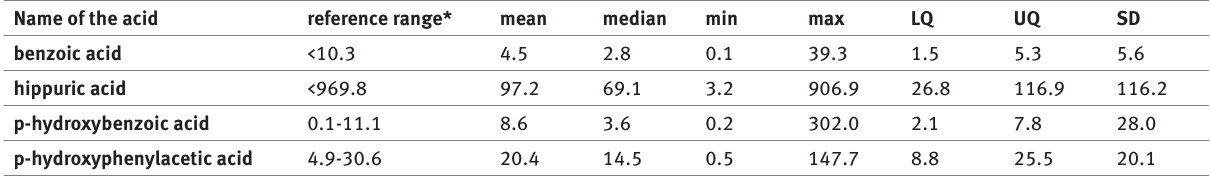
Table 1 Values obtained for quantification of determined acids (μmol/mmol of creatinine) in urine samples of all tested population of ASD